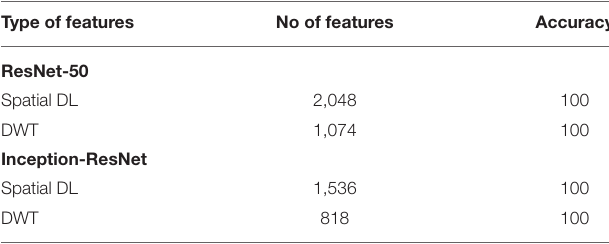
TABLE 3 | Binary classification accuracy (%) and number of features before and after DWT for ResNet-50 and Inception-ResNet CNNs. Type of